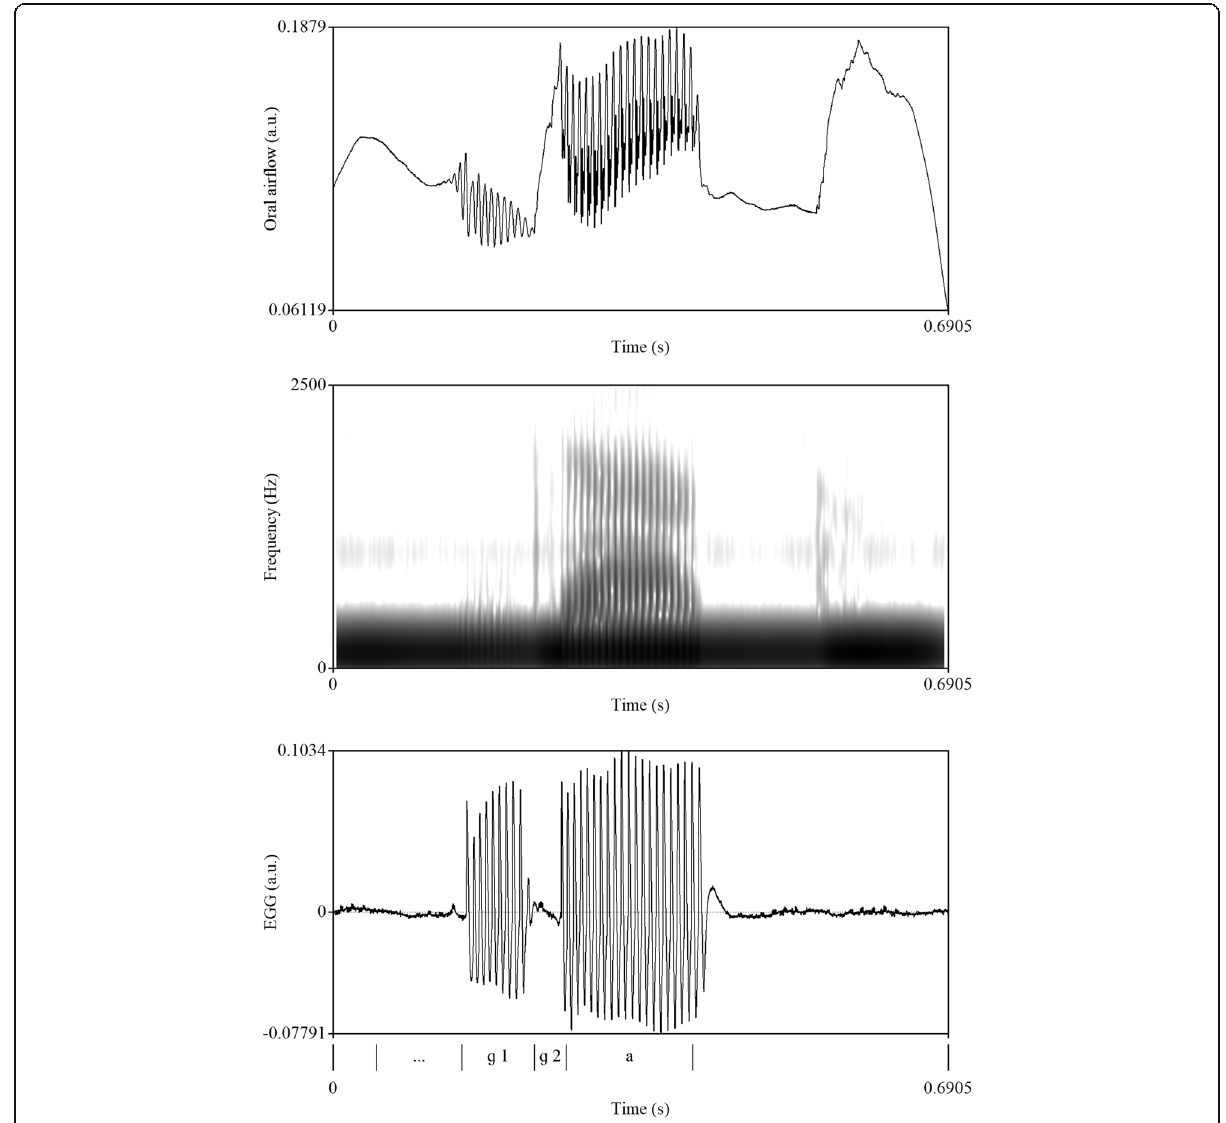
Fig. 2 Oral airflow and EGG signals of SP1 ’ s production of the word <gato>. From top to bottom: oral airflow waveform; spectrogram of oral airflow signal; EGG signal waveform; annotation (phone 1 is silence [ … ]; phone 2 [ ɡ ] is divided into two intervals — closure ( ɡ 1) and release ( ɡ